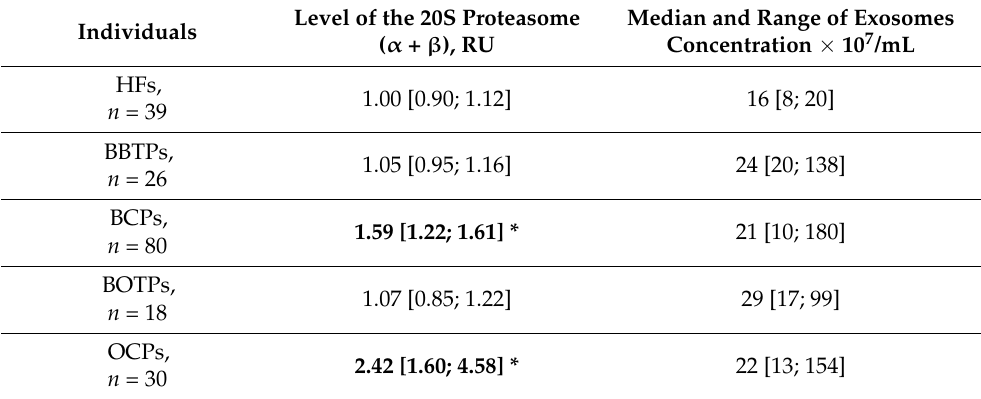
Table 3. The level of exosomal 20S proteasome and concentration of plasma exosomes from healthy female and tumor